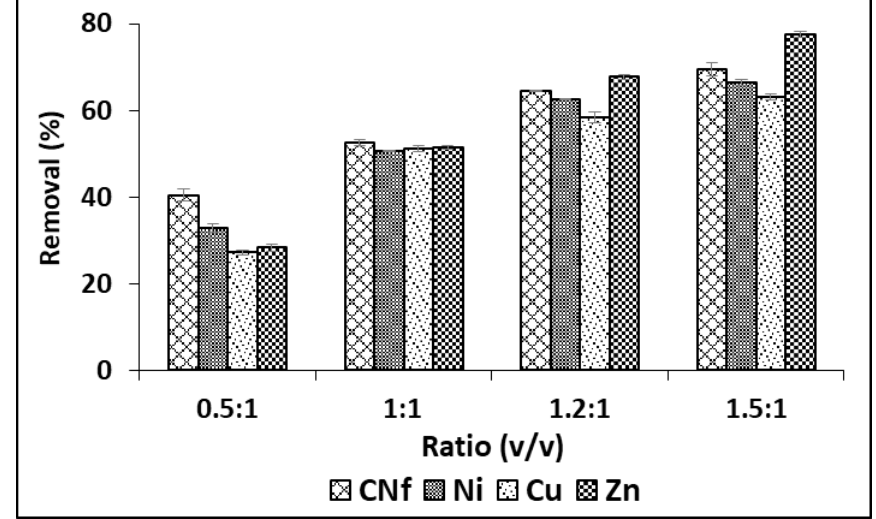
Figure 2. Percentages of removal of free cyanide and heavy metals onto CAB using different ratios between bioadsorbent/raw wastewater.